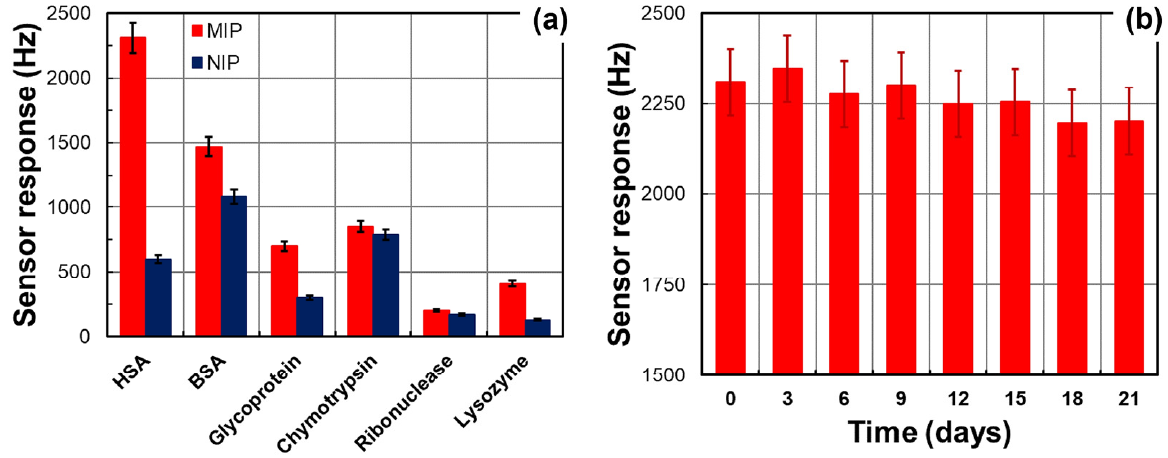
Figure 7. ( a ) The cross-sensitivity of HSA sensors toward different proteins, and ( b ) the stability and repeatability of the HSA sensor demonstrated by its sensor response to 200 ng/mL HSA over a period of 3 weeks.